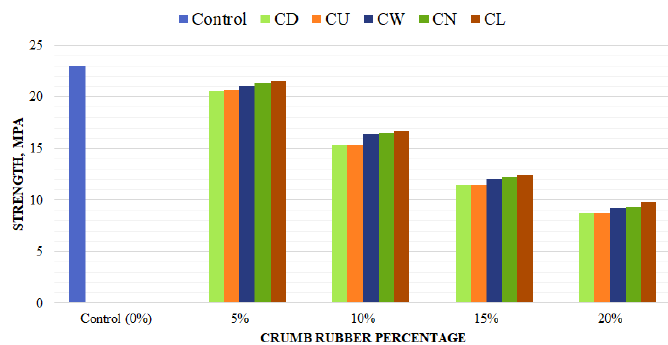
Figure 9. Compressive strength at 28 days. Figure 10. Percentage of recovered strength loss at 7 and 28 days.